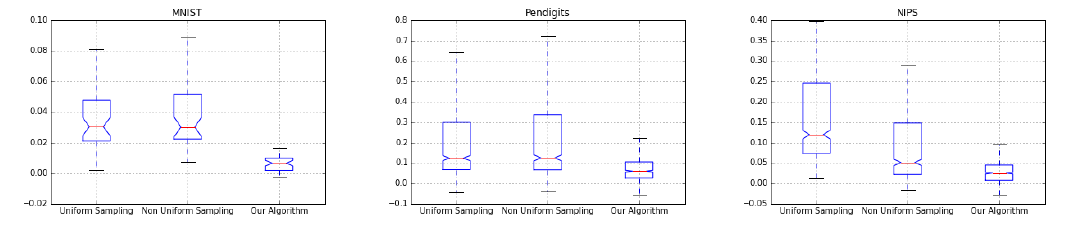
Figure 5. Error (y-axis) box-plots for real-data sets, ofline computation